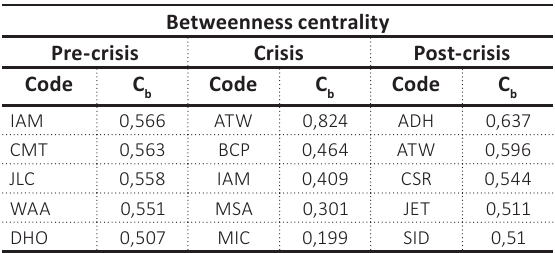
Table 6. The five highest values of betweenness centrality for the three periods Betweenness centrality Crisis